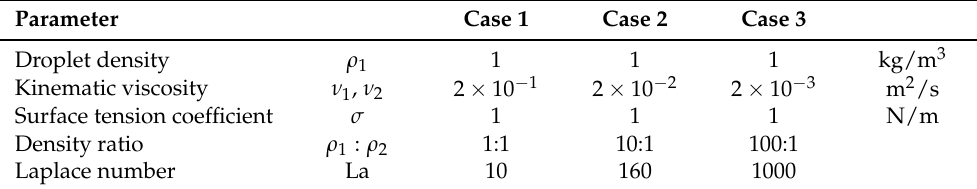
Table 2. A particle spacing of δ = L /100 was used for all simulations, resulting in a 970,000 particle simulation. A support radius of 3 h = 3 δ was used for all simulations. Table 2. Material and system properties for the square droplet cases.